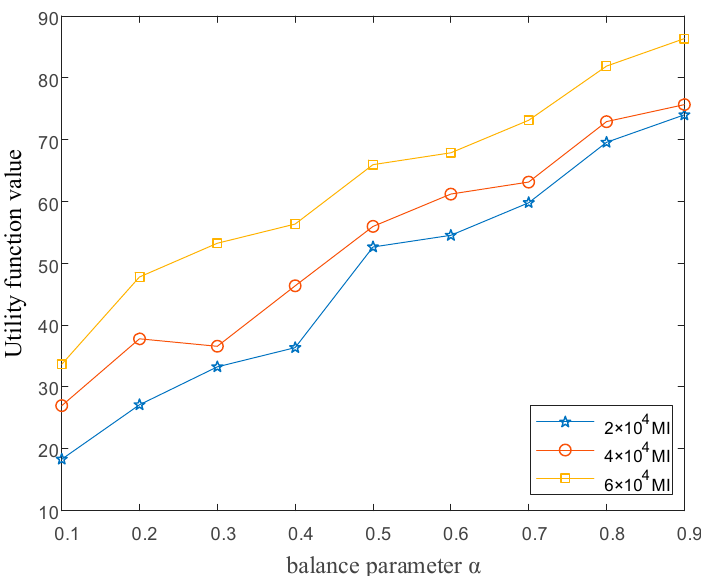
Figure 8. The graph of the value of the utility function as a function of equilibrium parameters.